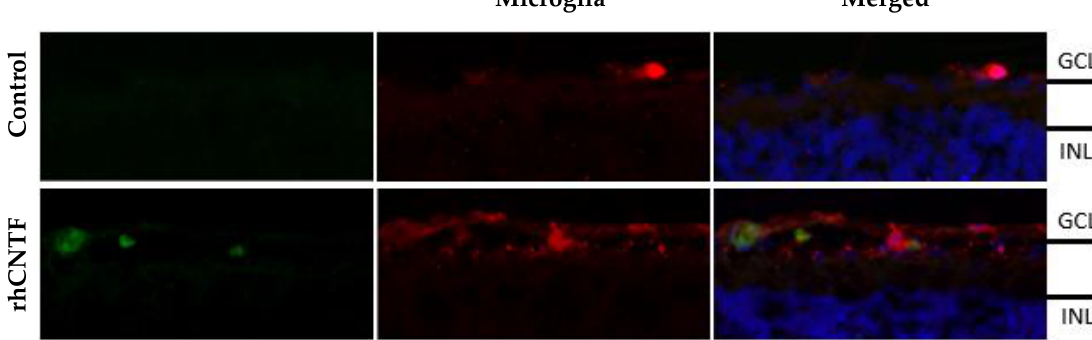
RPE, retinal pigment epithelium.